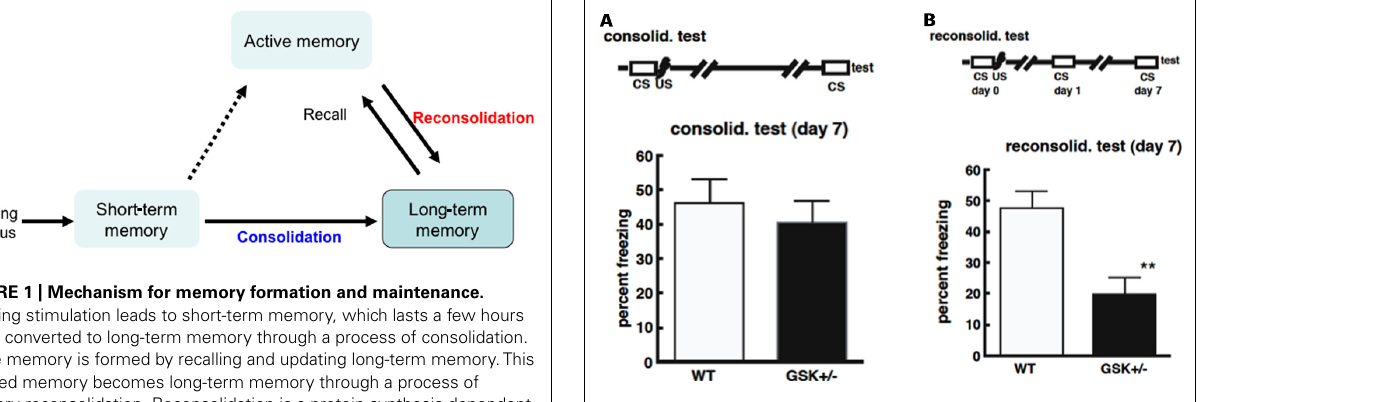
FIGURE 2 | (A) Deficiencies in GSK-3 β do not affect the process of memory consolidation. Mice were placed in a novel environment for 5 min (CS) and then subjected to three sequential foot-shocks (US). On day 7 after conditioning, animals were placed in the original environment, without shocks, for 5 min.The freezing time was recorded for these animals. (B) Deficiencies in GSK-3 β impair memory reconsolidation. Mice were placed in the environmental for 5 min (CS), and then subjected to three sequential foot-shocks (US). One day after conditioning, animals were exposed to the same environment for 5 min. Six days after their first exposure to conditioning, animals were re-exposed again and the freezing time was